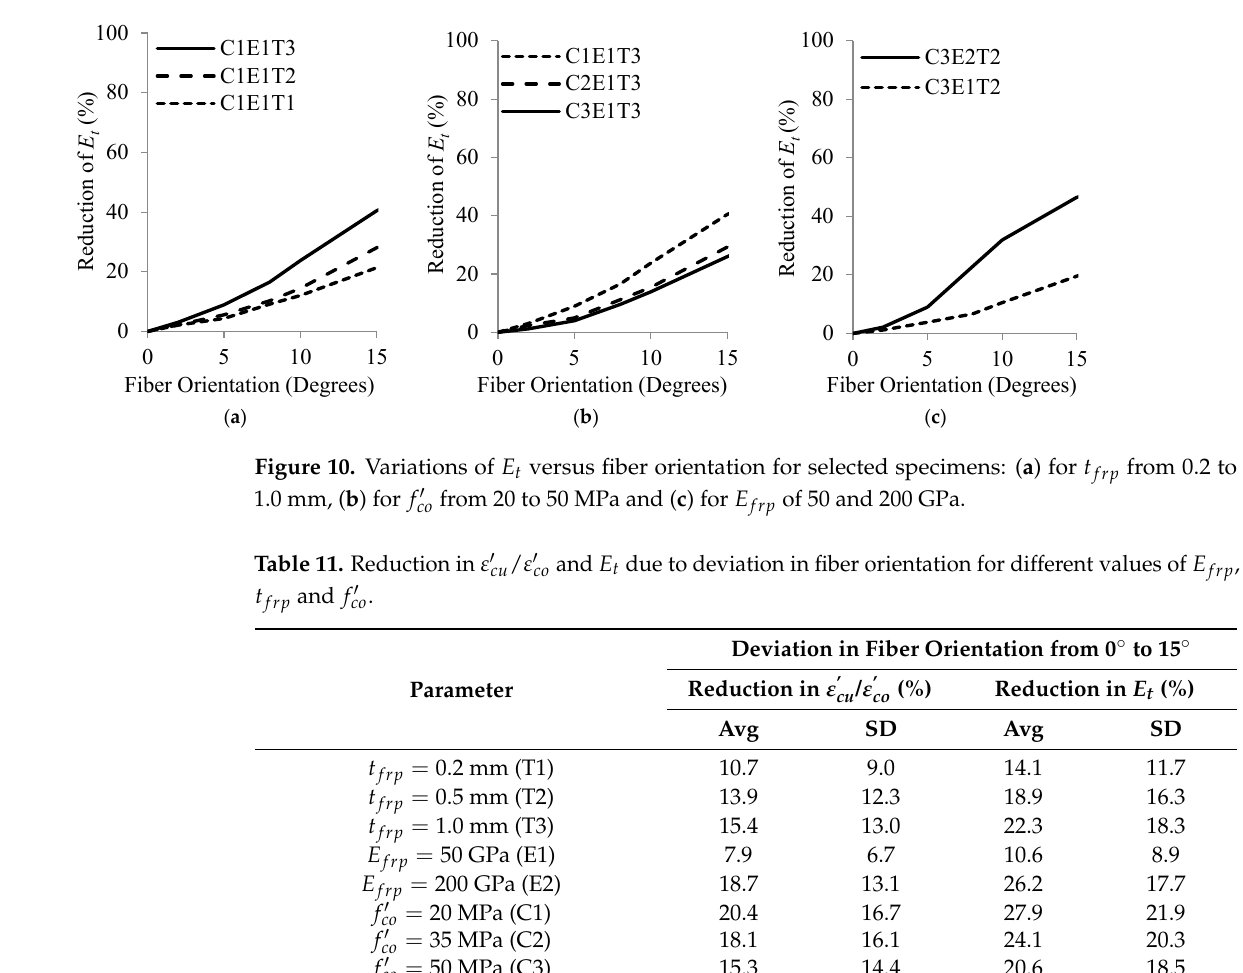
Table 12. Overall reduction in 𝜀 (cid:3030)(cid:3048)(cid:4593) /𝜀 (cid:3030)(cid:3042)(cid:4593) and 𝐸 (cid:3047) for different fiber orientations.